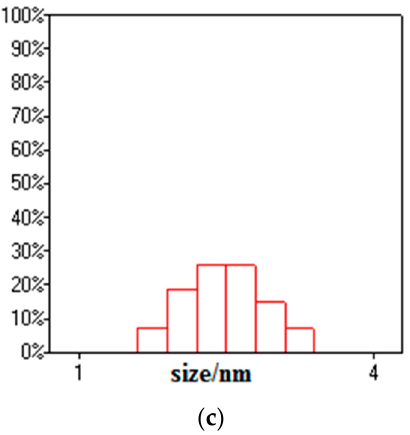
Figure 5. Diameter distribution of ( a ) B-nZVI, ( b ) GO-B-nZVI, and ( c ) core–shell structure of nZVI.